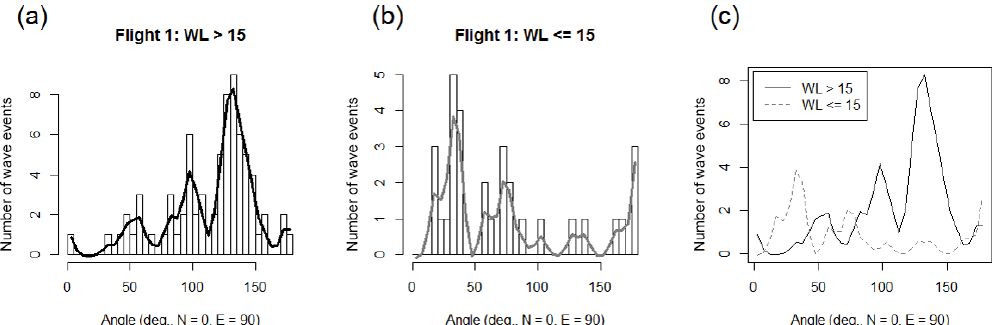
Figure 9. If wavelength and propagation direction are identical for at least six images separated by 30s at maximum (parameter n ), this wavelength is denoted as a wave event. Wave events must be present for more than 10s at least (time difference between first and last occurrence, parameter t ). (a) and (b) depict the histograms of propagation directions (180 ◦ ambiguity, 5 ◦ bar width) smoothed by a cubic spline for wave events with horizontal wavelengths longer and shorter than 15km for flight 1. (c) shows both splines in one plot (black and grey: wavelength longer and shorter than 15km). Smaller n and t change the absolute values for wavelengths longer than 15km but not the qualitative results. Wavelengths shorter than 15km are more sensitive to these parameters (especially to n ) but with a stable peak at ca. 40 ◦